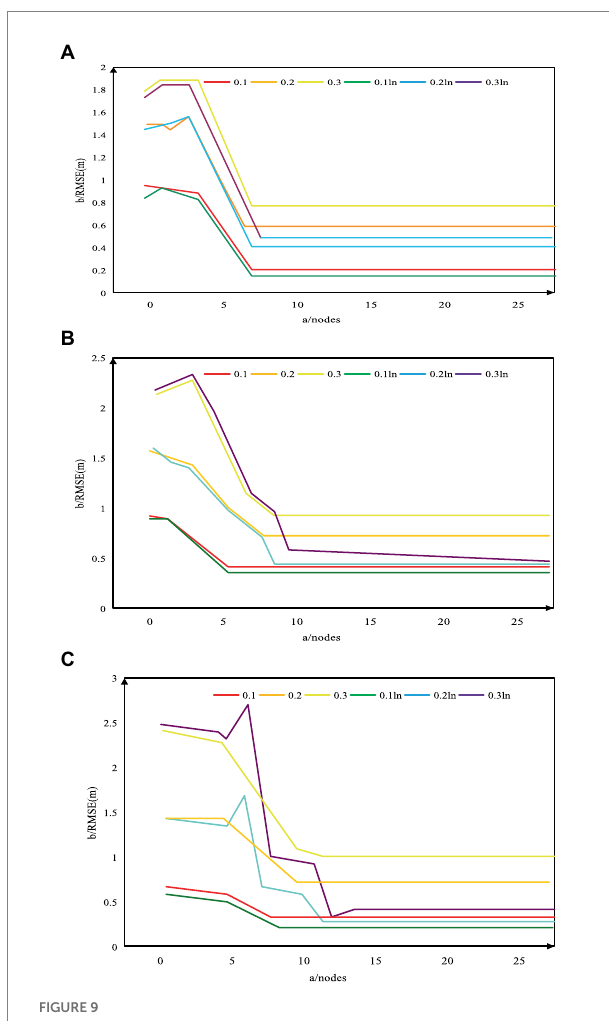
FIGURE 9 Different values and different drift error positioning results. (A) The positioning results of different drift errors when the value is 0. (B) The positioning results of different drift errors when the value is 0.5. (C) The positioning results of different drift errors when the value is